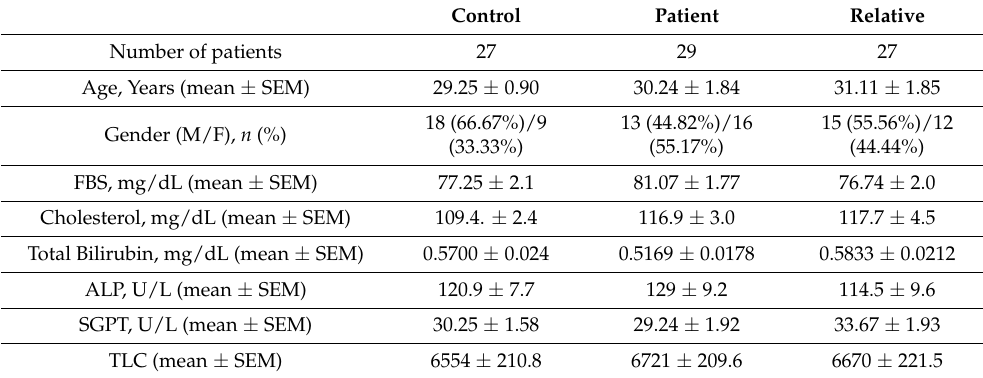
Table 1. Demographic profile of depressive patients, their first-degree relatives, and healthy controls. Control Patient Relative Number of patients 27 29 27